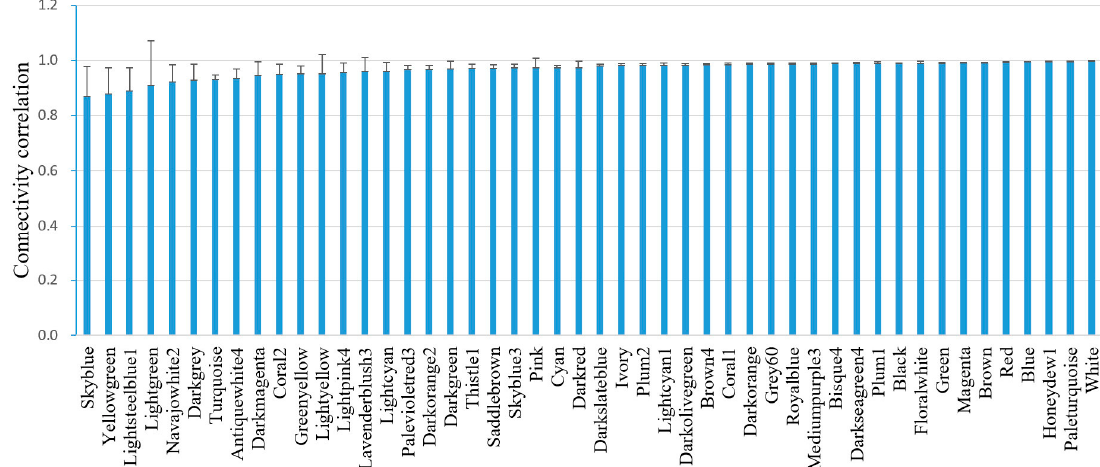
Figure 1. Correlation of intramodule connectivity for each module after 1000 instances of sampling (mean ± standard deviation (SD)). The connectivity values were calculated by sampling 1050 samples 1000 times randomly.